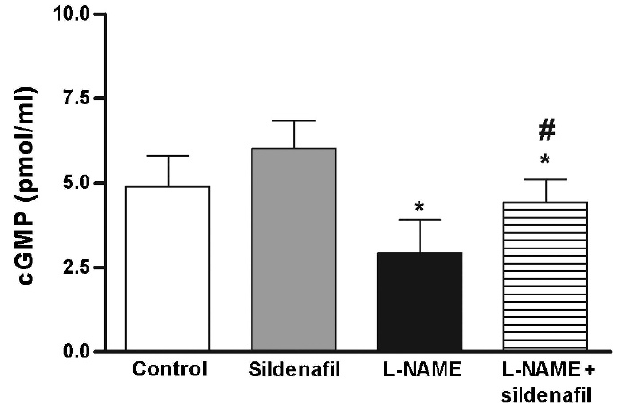
Figure 3 - The plasma cGMP levels after eight weeks of treatment in the control (open column, n=15), L-NAME (black column, n=15), sildenafil (grey column, n=15) and L-NAME + sildenafil (horizontally striped column, n=15) groups. The bars represent the mean ¡ SEM. * p , 0.05 vs. control group; # p , 0.05 vs. L- NAME